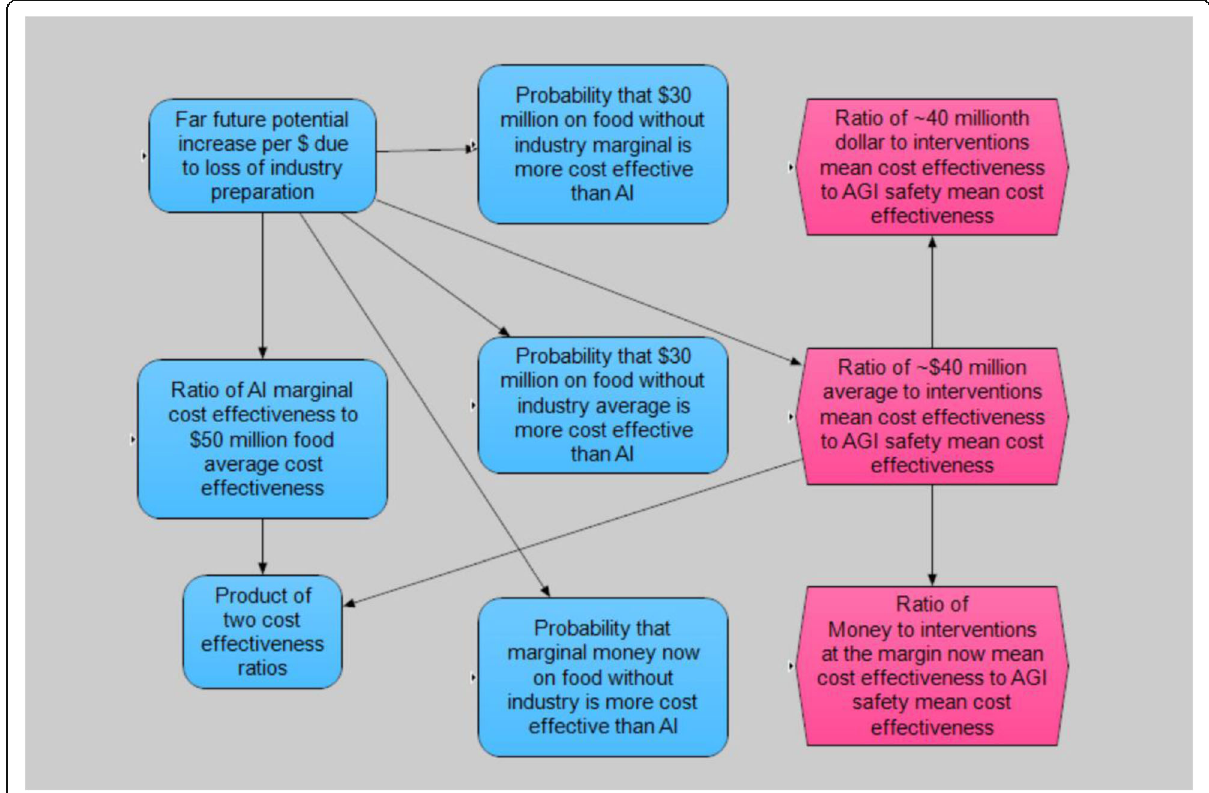
Fig. 5 Overall cost-effectiveness ratios